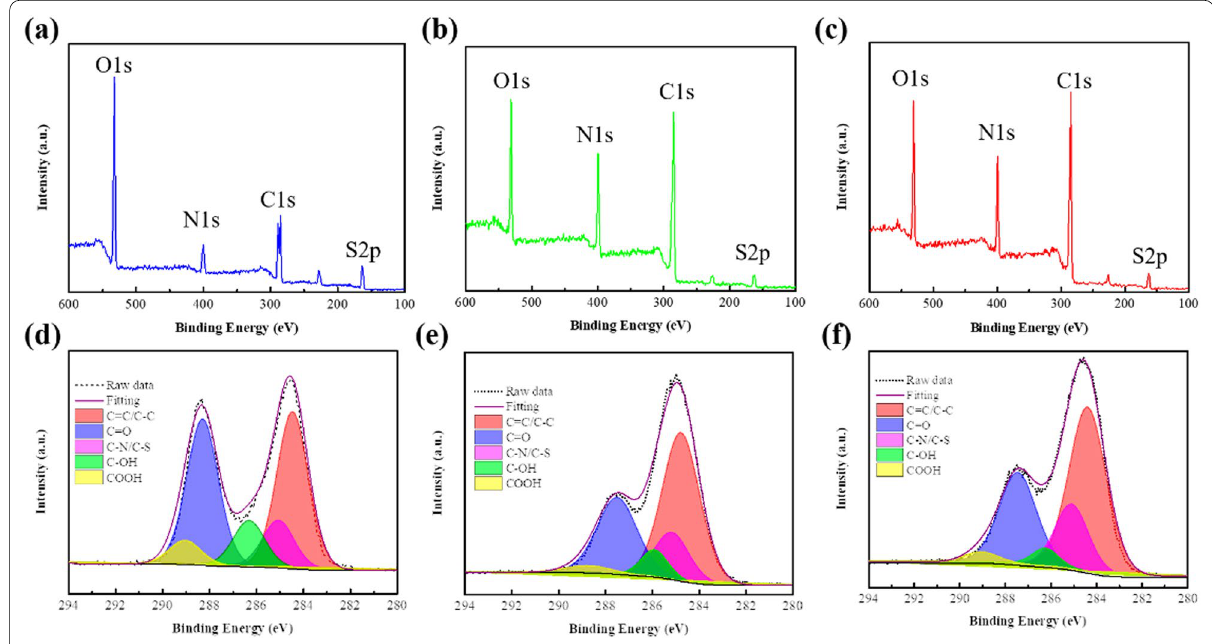
Fig. 4 XPS full-scan survey analysis of a b-CDs, b g-CDs, c r-CDs and C1s high-resolution level spectra of d b-CDs, e g-CDs and f